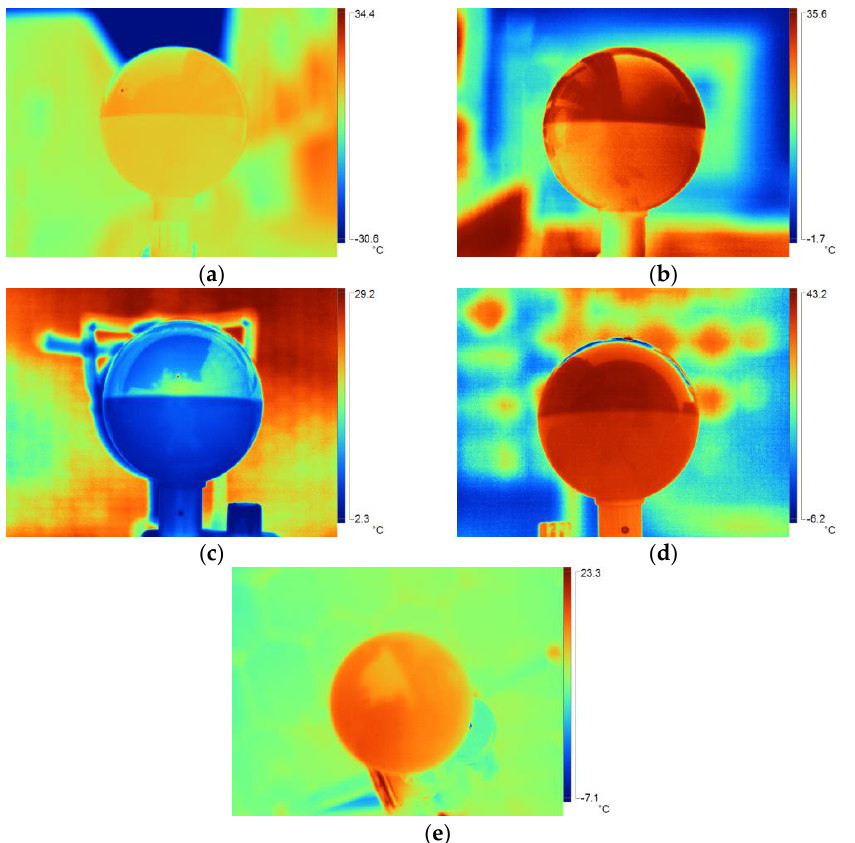
Figure 9. Thermal image of the black sphere at five angles: ( a ) east, ( b ) west, ( c ) south, ( d ) north, and ( e ) top. Table 7. The surface temperature of the black sphere at each angle (°C).